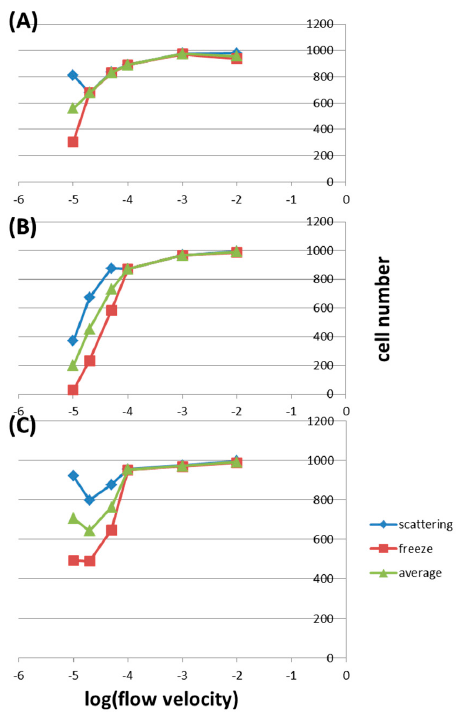
Figure 4. The cell numbers counted in the outlet under different wall conditions and flow velocities in ( A ) the vertical inlet; ( B ) the parallel inlet; and ( C ) the vertically parallel inlet. After this point, the average cell numbers decrease obviously with deceasing velocity down to 0.00002 m/s, being 761.5 and 742.5 for 0.001 and 0.0001 m/s, respectively. However, this number increases to 706.5 at 0.00001 m/s. We speculate that (1) for velocities between 0.01 and 0.0001 m/s, the force due to flow is strong enough to bring almost all cells across the interface; (2) for velocities between 0.0001 and 0.00002 m/s, the gravity forces some cells to sediment onto the interface of the tube end; (3) at a velocity of 0.00001 m/s, cells about to sediment as described in (2) have more time to move along the streamline and across the interface without being greatly affected by the gravity. Depending on the application of the microfluidic chip, the inner wall of the fluidic channel should be modified correspondingly. To capture as many cells as possible within the micro-channel, the wall is modified to be hydrophilic or coated with specific biomolecules (e.g., antibodies or antigens). In this case, the